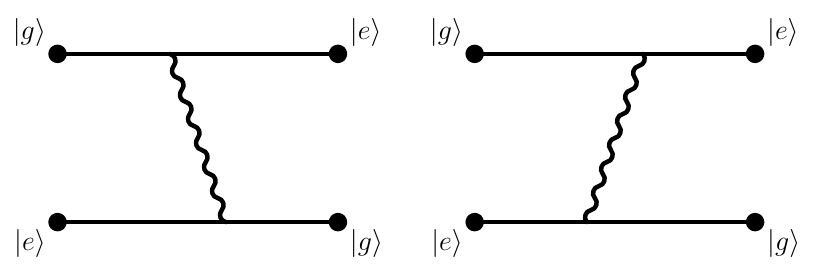
Figure 1. Diagrams are given for the exchange of a virtual photon of angular frequency ω 0 between two identical atoms. The two different time orderings are written out explicitly for illustration, even if, in the language of Feynman diagrams of quantum electrodynamics [2], the diagrams are considered to be identical. The ground state is denoted as